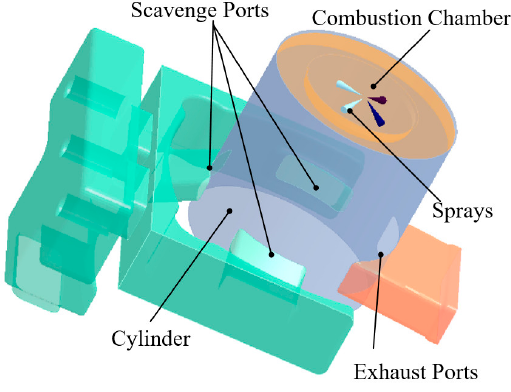
Figure 1. Configuration of the actual engine. Table 1. The type and geometric parameters of